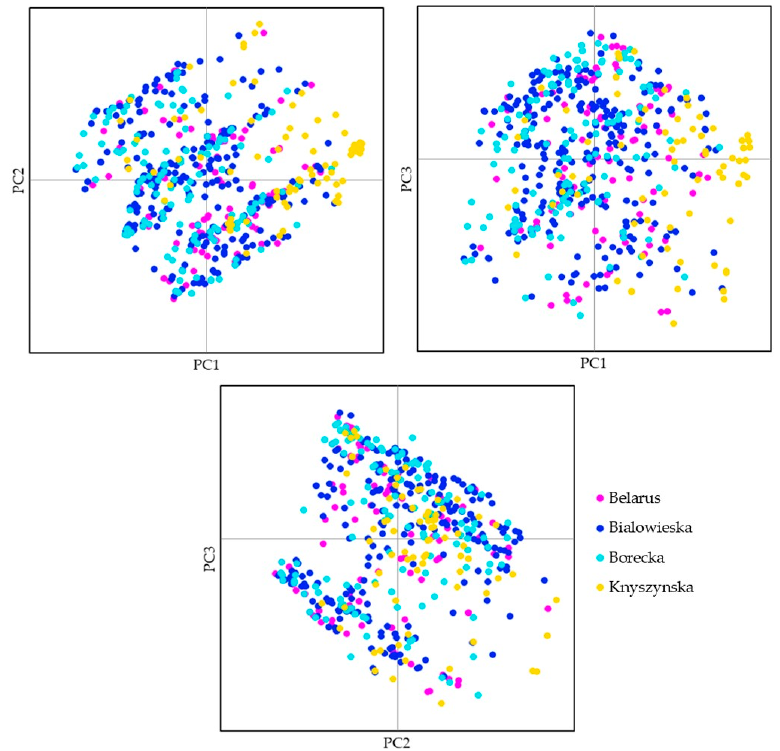
Figure 5. Principal Coordinate Analysis (PCA) of 4 populations, based on 10 microsatellite markers (PC1 = 19.41%; PC2 = 16.15%; PC3 = 13.08%).